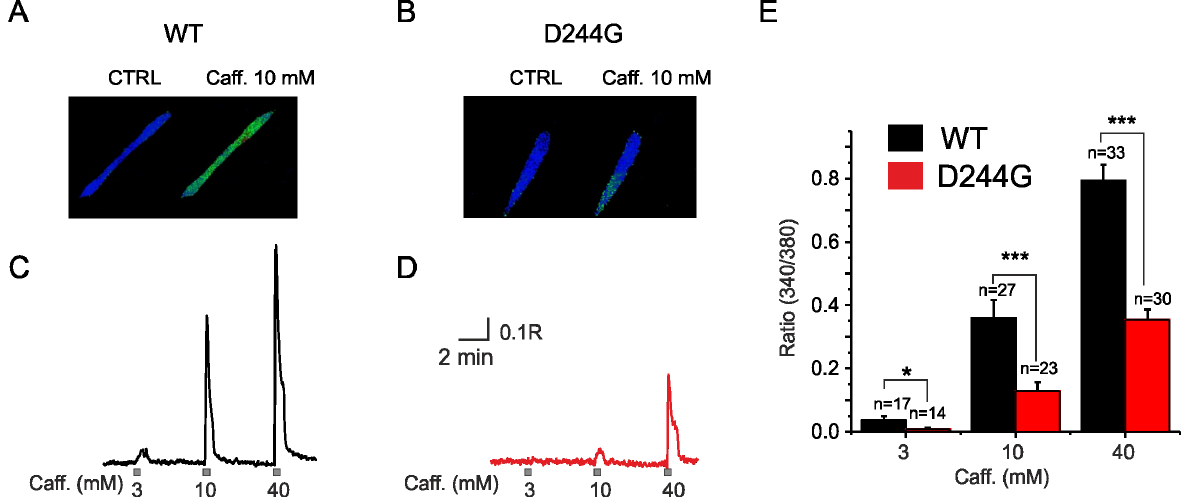
Fig 7. Sarcoplasmic Ca 2+ signals elicited by caffeine in control vs D244G myotubes. Representative fluorescence images from fura-2-loaded control ( A ) and patient ( B ) myotubes before (CTRL) and during caffeine application (Caff 10 mM). Sample traces showing signals elicited by caffeine (Caff 3, 10, 40 mM) and recorded from myotubes derived from controls ( C ) and patients ( D ). ( E ) Bar graph showing the mean Ca 2+ signals elicited by different caffeine concentrations from control ( black ) and D244G ( red ) myotubes. Data are means with error bars representing SEMs; the number of myotubes from which Ca 2+ signals were measured is shown above each bar ( * p < 0.05; *** p < 0.001).